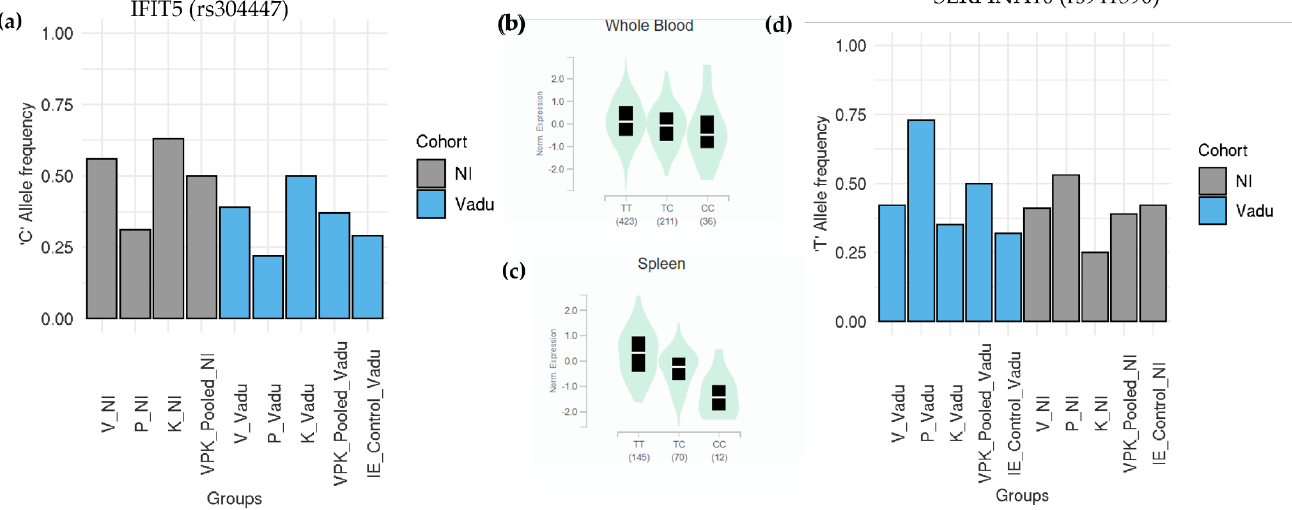
Figure 4. ( a ) Bar plot for alternate allele frequency in missense SNP rs304447 in IFIT5 gene across Prakriti groups, IE Control and Pooled population (V, P, K combined) from NI and Vadu cohort. Frequency of the alternate allele “C” is significantly lower in the Pitta group than Kapha ( p < 0.01 NI, p < 0.02 Vadu). Background control frequency of rs304447 could not be obtained for NI cohort. ( b , c ) Violin plots for normalized expression across Whole Blood & Spleen from GTEx v8. Alternate allele “C” is linked with lower IFIT5 expression. ( d ) Bar plot for reference allele frequency “T” in missense SNP rs941590 in SERPINA10 gene across Prakriti groups, IE control and Pooled population (V, P, K combined) from NI and Vadu cohort. Frequency of the reference allele “T” is significantly higher in the Pitta group than the Kapha ( p < 0.03 NI, p < 0.002 Vadu). This allele also significantly differentiates